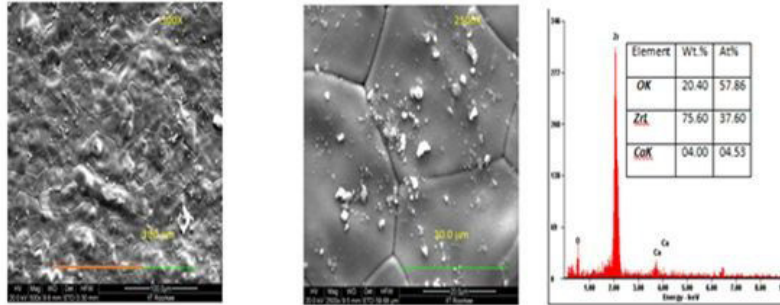
Figure 5. SEM and EDS analysis of CSZ with 9 mol% CaO.